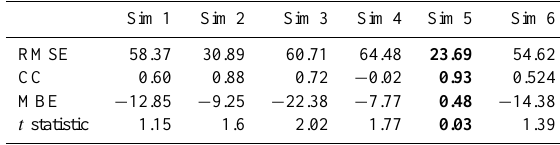
Table 4. Statistical evaluation of different simulations for SHF.